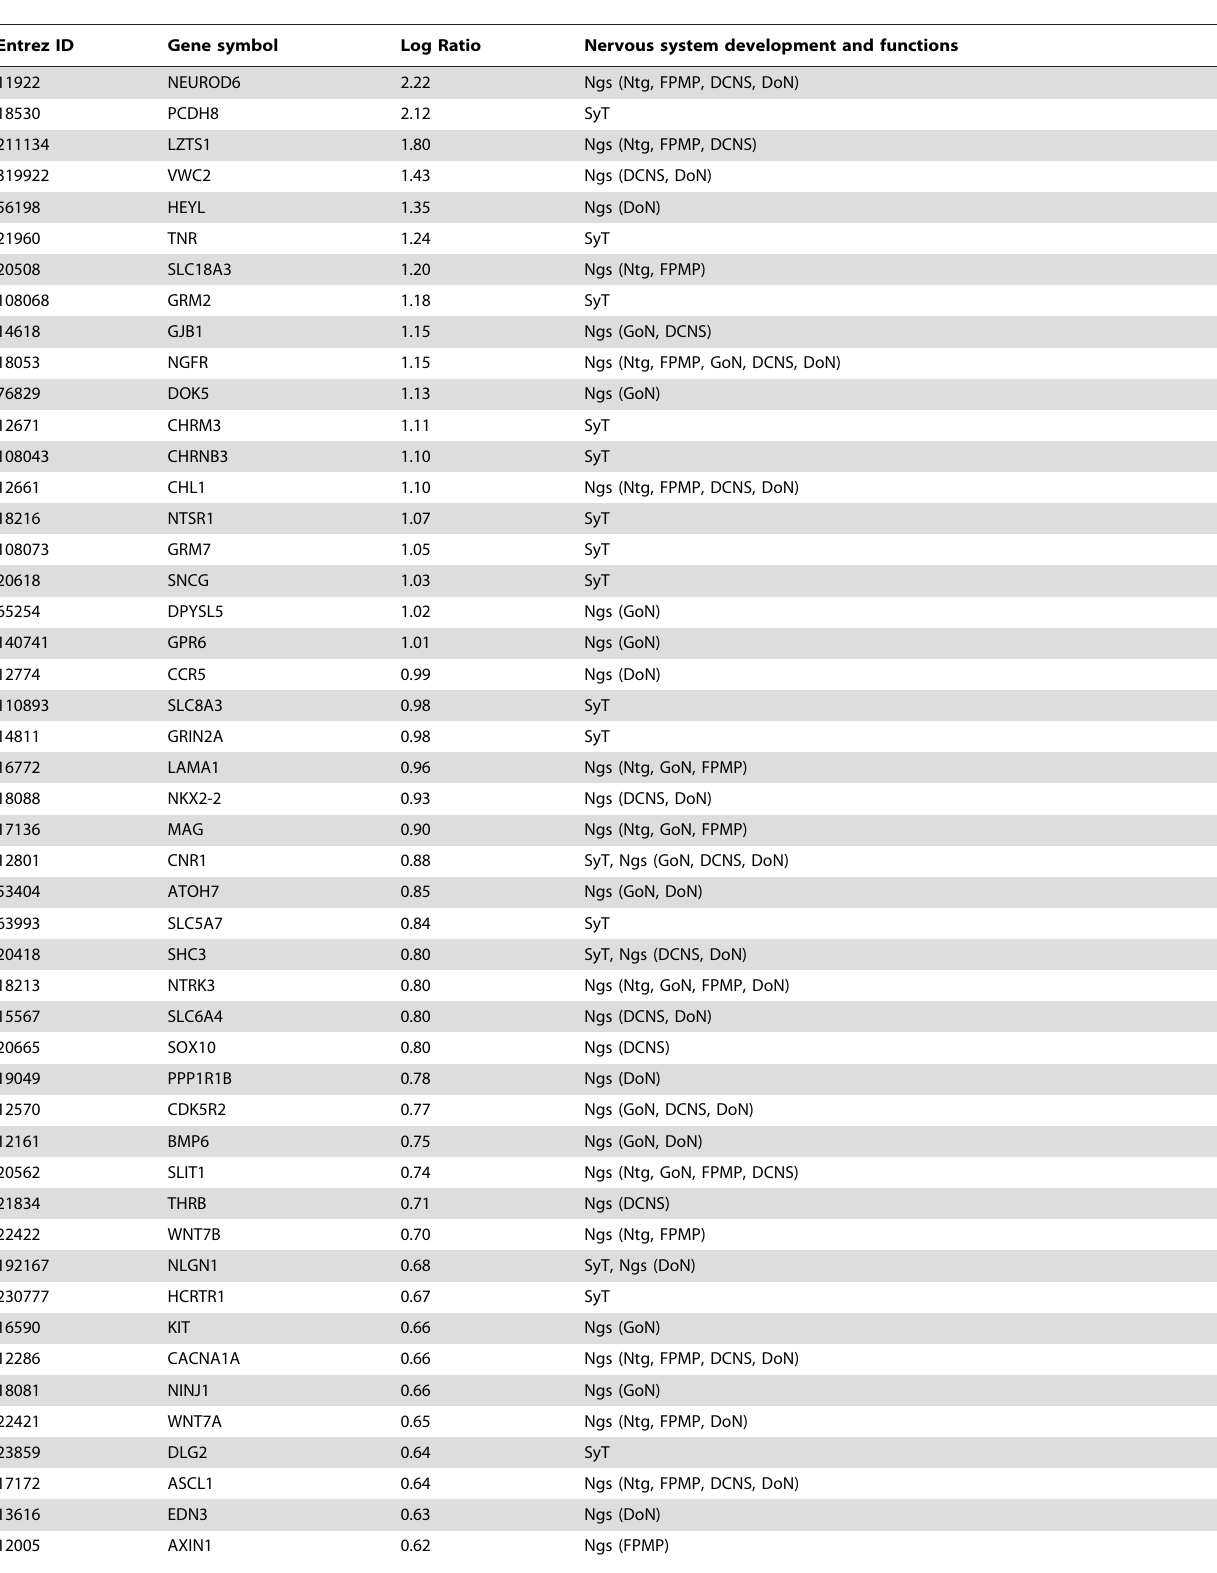
Table 5. The genomic candidates associated with two top-ranked ‘‘nervous system development and functions’’: neurogenesis (Ngs) and the synaptic transmission